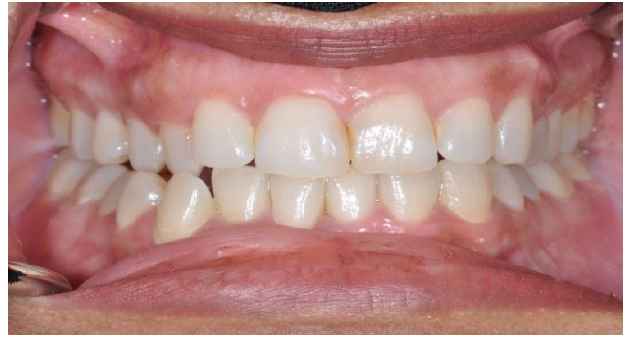
Fig. 8. five years follow-up.